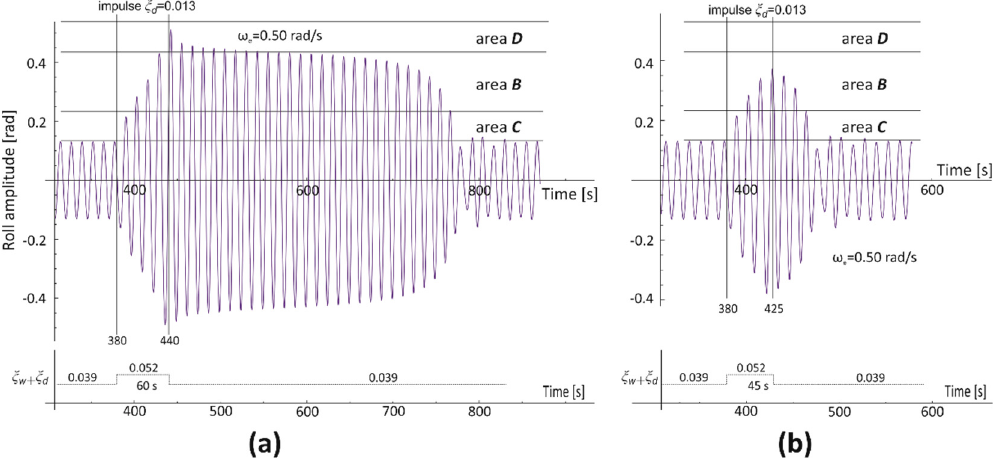
Figure 9. Roll time history for the OSV vessel ( T = 6.10 m, GM 0 = 2.50 m, ξ w = 0.039). The transition from the area below the bistability area C in the direction of the resonance area D . The reaction to the additional exciting moment: ( a )— ξ d (380–440 s) = 0.013; ( b )— ξ d (380–425 s) = 0.013.